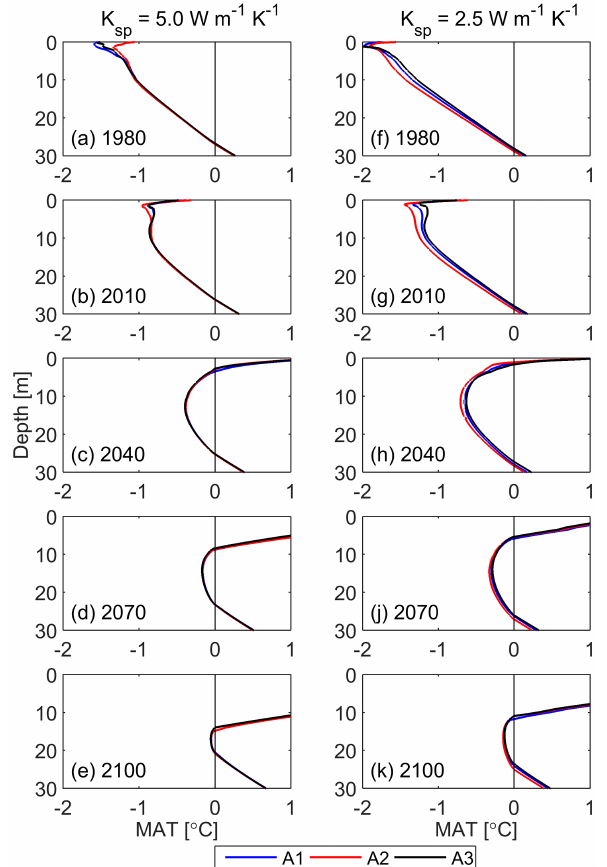
Figure 12. Comparison of the influence of soil architecture and thermal conductivity of soil particles ( λ sp ) on permafrost degrada- tion with simulations over the period from 1980 to 2100. (a–e) An- nual mean ground temperature (MAT) of A1, A2 and A3 with a high λ sp = 5.0Wm − 1 K − 1 at selected years; (f–j) the same as (a–e) but with a low λ sp = 2.5Wm − 1 K − 1 .